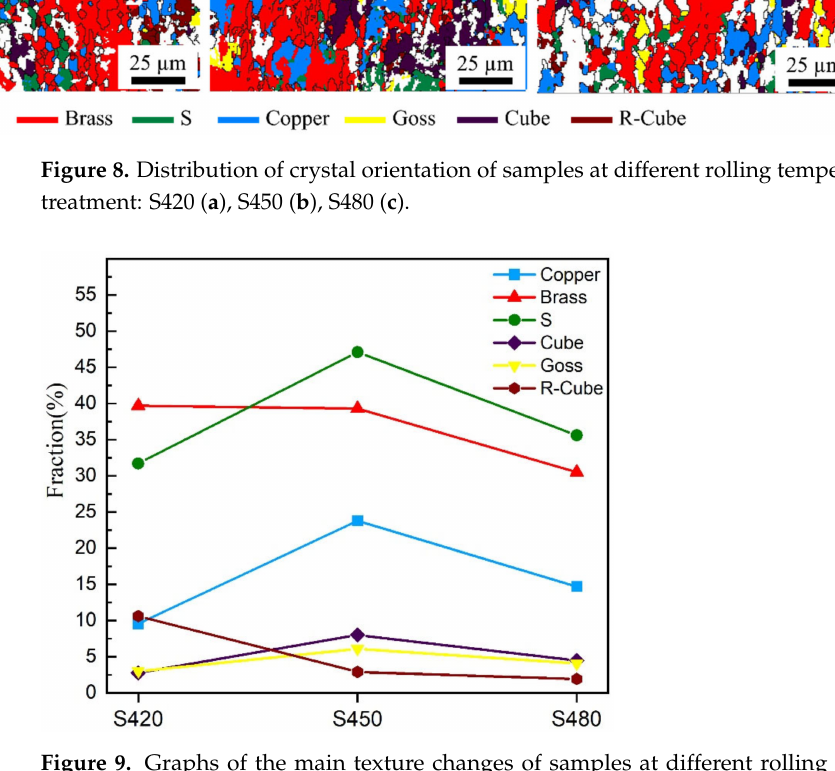
Figure 9. Graphs of the main texture changes of samples at different rolling temperatures after aging